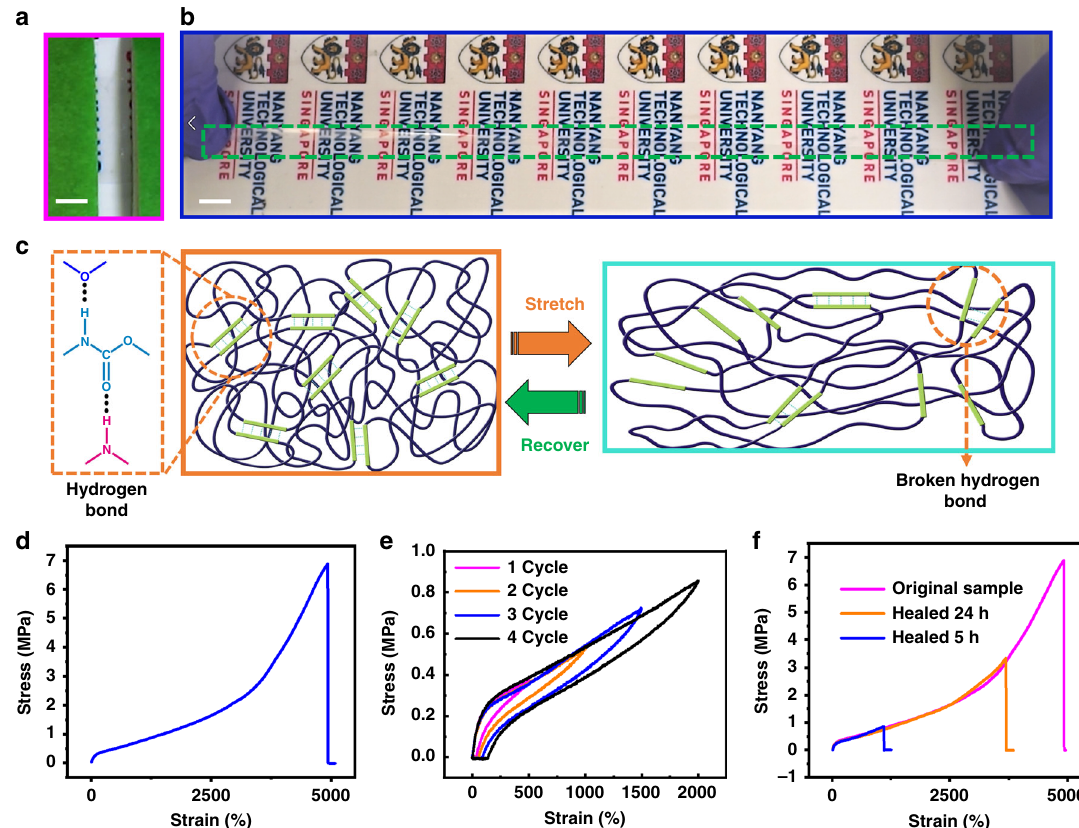
Fig. 1 Digital photo and mechanical properties of the stretchable polyurethane acrylate elastomer. Digital photo of the PUA elastomer at strains of a 0% and b 3000%. Scale bar: 5 mm. c Schematic illustration of the breaking and reforming of hydrogen bonding resulting in high stretchability. d Tensile stress – strain behavior of the polyurethane acrylate (PUA) fi lm. e Tensile loading and unloading data of the PUA for evaluation of its hysteresis behavior. f Stress – strain behavior of the self-healed PUA fi lm with different healing time at 100 °C. Deformation rate for all measurements: 100 mm min −